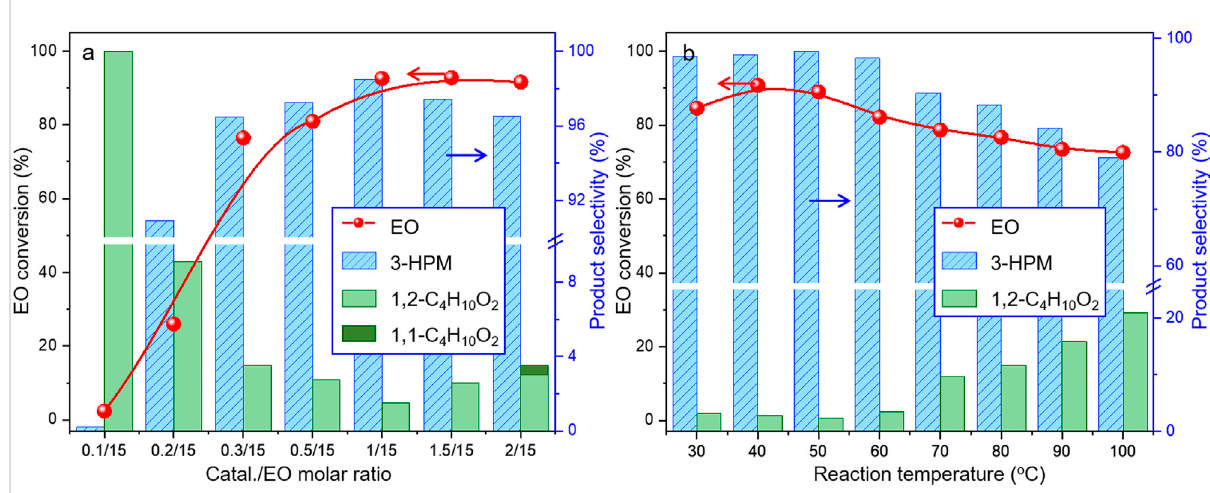
FIGURE 1 Catalytic performances of Co 2 (CO) 8 for carbonylative transformation of EO as a function of (A) molar ratio between Co and EO at 40 ° C and (B) reactiontemperature.Reaction condition:6 MPa COfor4 h;Co/3-hydroxypyridine =1:2;andCo/EO =1/15, balancedwithmethanol,1,1-C 4 H 10 O 2 : 1,1-Dimethoxyethane, and 1,2-C 4 H 10 O 2